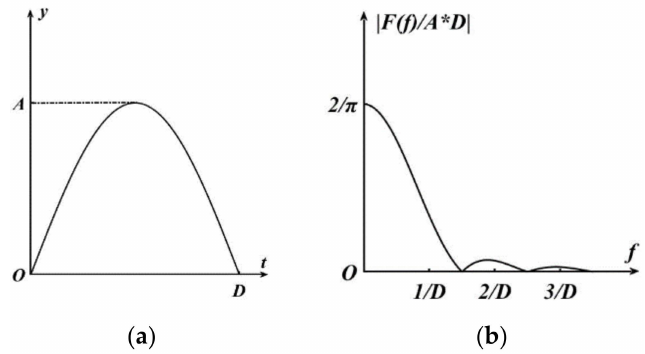
Figure 6. ( a ) Half-cycle sine shock pulse of amplitude A and pulse duration D . ( b ) Spectrum of the half-cycle sine shock